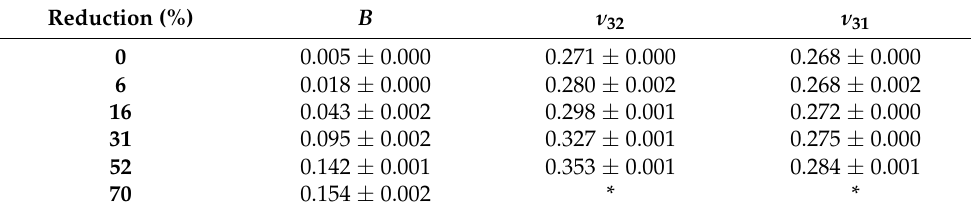
Table 4. Birefringence and Poisson’s ratio vs. reduction by cold rolling.